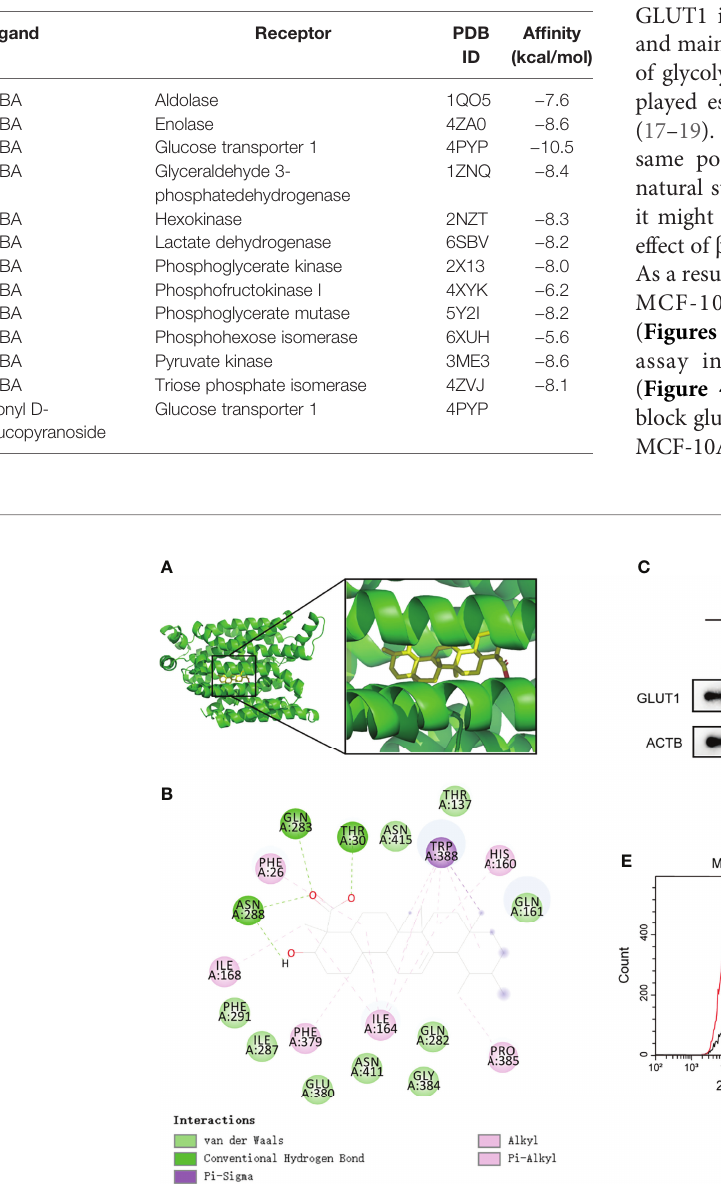
TABLE 1 | Molecular docking scores (kcal/mol) of hit molecules with PDB IDs.